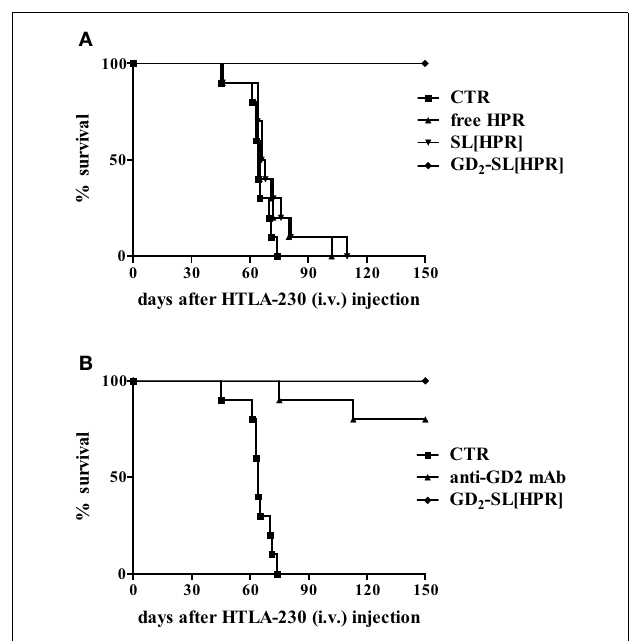
FIGURE 1 | Survival of neuroblastoma-bearing mice after treatment with fenretinide (HPR)-containing nanocarriers . Nude mice were injected intravenously with 3 × 10 6 HTLA-230 cells, and treated 4h after with the following HPR formulations for 5days: (A) Hepes Buffer pH 7.4, control (CTR); free HPR, 15mg/kg/total dose; SL(HPR), 15mg/kg/total dose; GD 2 -SL(HPR), 15mg HPR/kg/total dose (containing 2mg mAb/kg/total dose). In a second experiment (B) , a group of mice were treated with